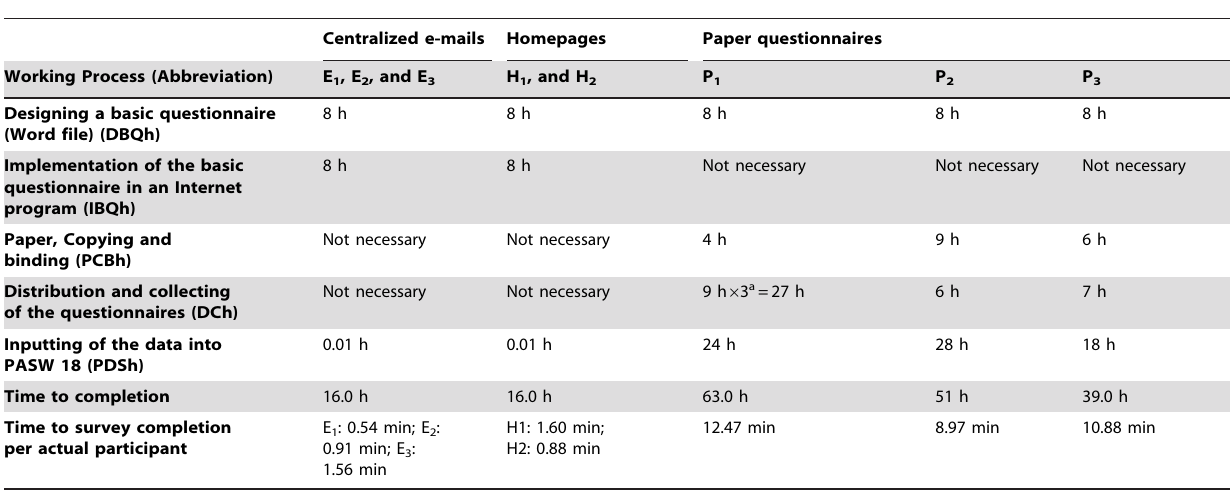
Table 2. Time costs of the surveys ( a three students working